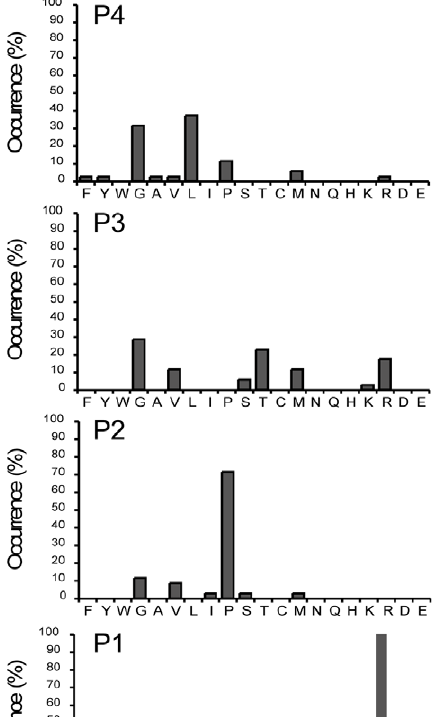
Figure 2. Amino acid frequency in positions P4 to P4 9 of thrombin-susceptible phage sequences. This analysis is based on the alignments shown in Figure 1A and 1B. For clarity, amino acids are displayed in functional groups, starting to the left with aromatic residues, and ending with acidic residues to the